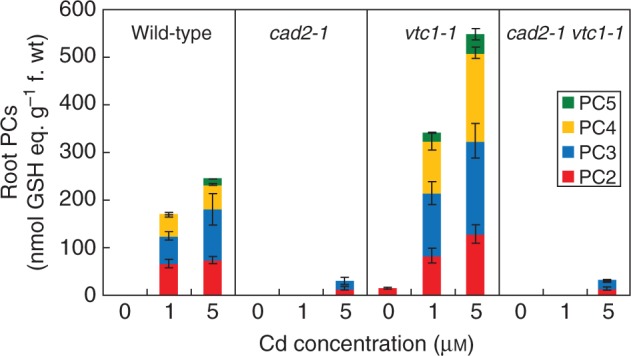
Profiling the phytochelatin (PC) content (see key) in four Arabidopsis thaliana genotypes (wild-type, cad2-1, vtc1-1 and cad2-1 vtc1-1) in roots exposed to 0, 1 or 5 μm CdSO4 for 72 h in hydroponics (n = 4). Thiol content is expressed in GSH equivalents (nmol g–1 f. wt).